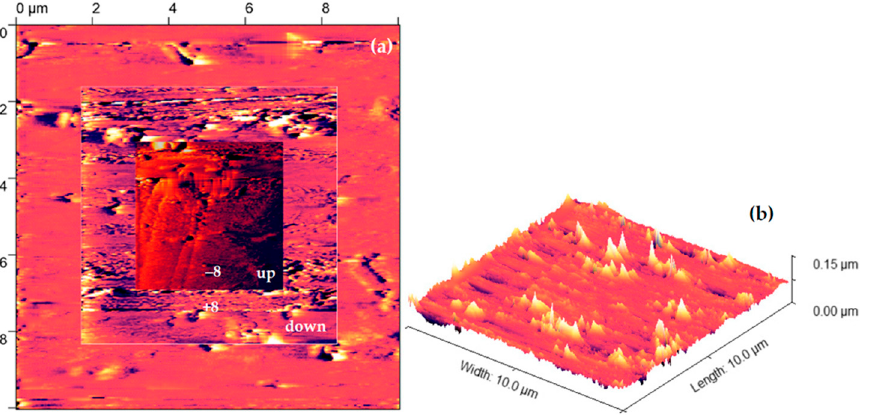
Figure 10. Topography of 100 nm thick BFO 100 nm Pt/Ti/Si ( a ) surface under +/ − 8 and 0 V bias ( b ) 3D topography.